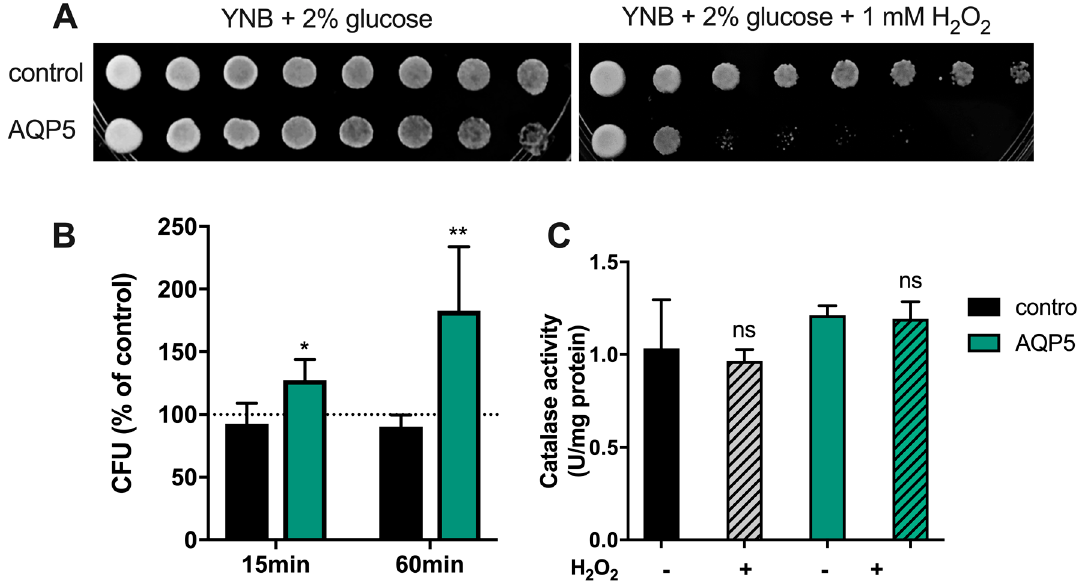
Figure 5. Yeast cell sensitivity assay and catalase activity under oxidative stress. ( A ) Growth assay of yeast cells on medium containing H 2 O 2 . Yeast suspensions were spotted at 10-fold dilutions on solid YNB plates without or with 1mM H 2 O 2 . Growth was recorded after two days at 28 °C. Photographs shown are representative of three independent experiments with consistent results. ( B ) Survival test of yeast cells in liquid culture after treatment with 1 mM H 2 O 2 for 15 and 60 min at 30 °C. Survival is expressed by the percentage of colony forming units (CFU) relative to untreated controls. Significance levels: * p < 0.05 and p < 0.01 vs. control. ( C ) Catalase activity before and after treatment with 1 mM H 2 O 2 for 60 min at 30 °C. Values are mean ± SEM of triplicates. Significance level: ns, non-significant vs. non-treated cells.